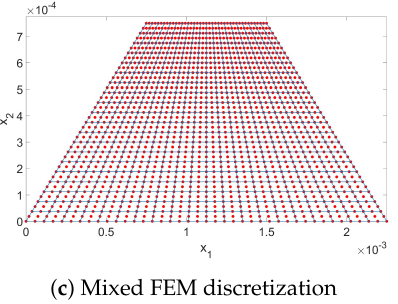
Figure 12. Schematic and IGA discretization of a truncated